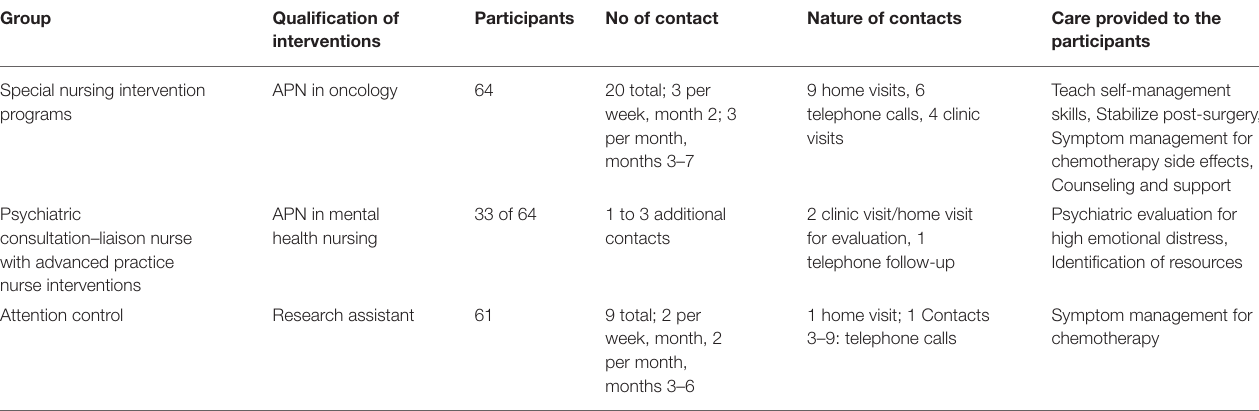
TABLE 1 | Schedule of contacts for intervention and attention control groups.